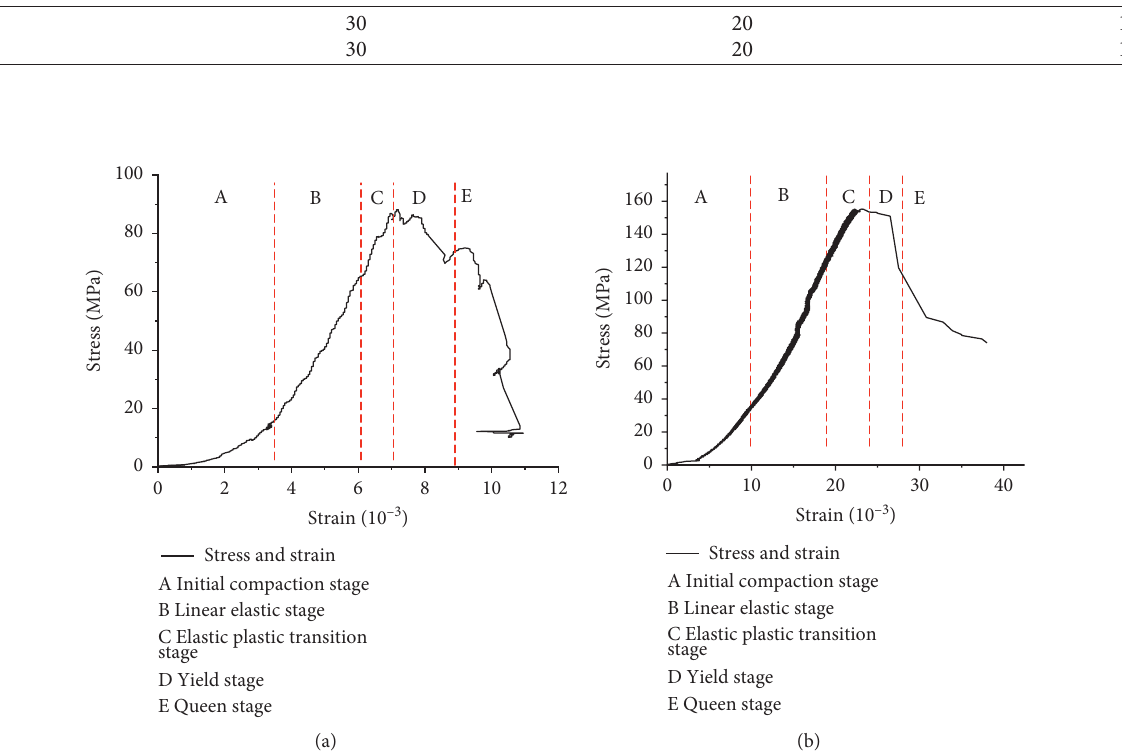
Figure 8: Stress–strain curves of marble samples: (a) uniaxial stress–strain curves and (b) stress–strain curves of samples with a borehole plus confining pressure.